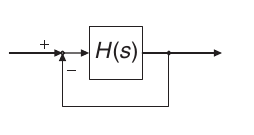
FIG. 7. Control loop with open loop transfer function H (cid:1) s (cid:2) .